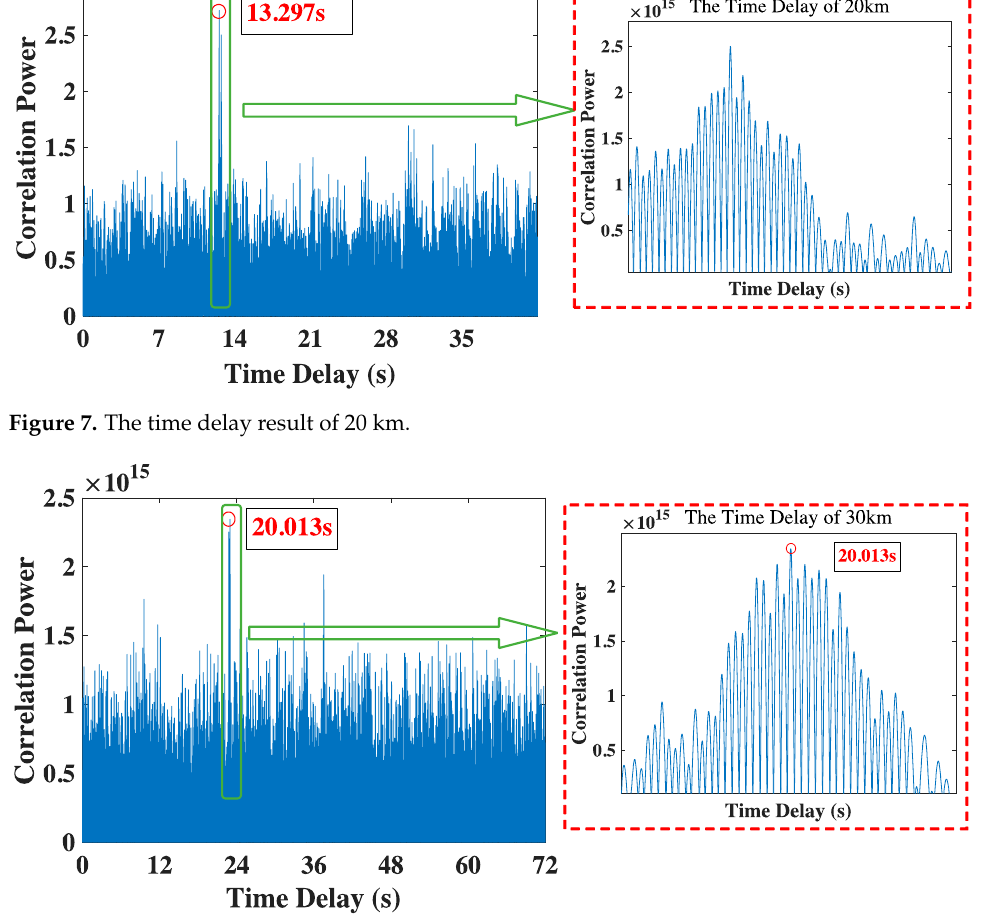
Figure 8. The time delay result of 30 km.